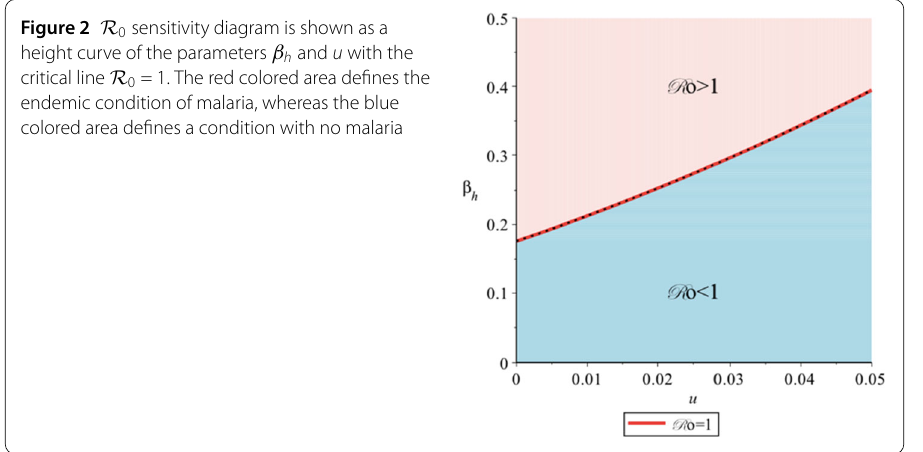
Figure 2 R 0 sensitivity diagram is shown as a height curve of the parameters β h and u with the critical line R 0 = 1. The red colored area defines the endemic condition of malaria, whereas the blue colored area defines a condition with no